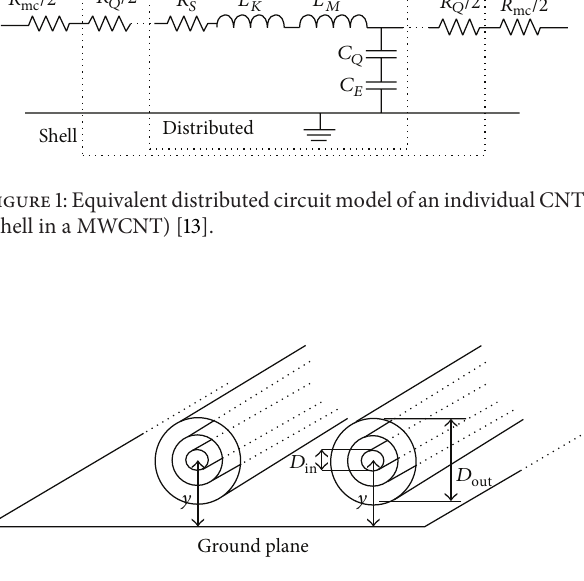
Figure 2: Two coupled MWCNTs over a ground plane.